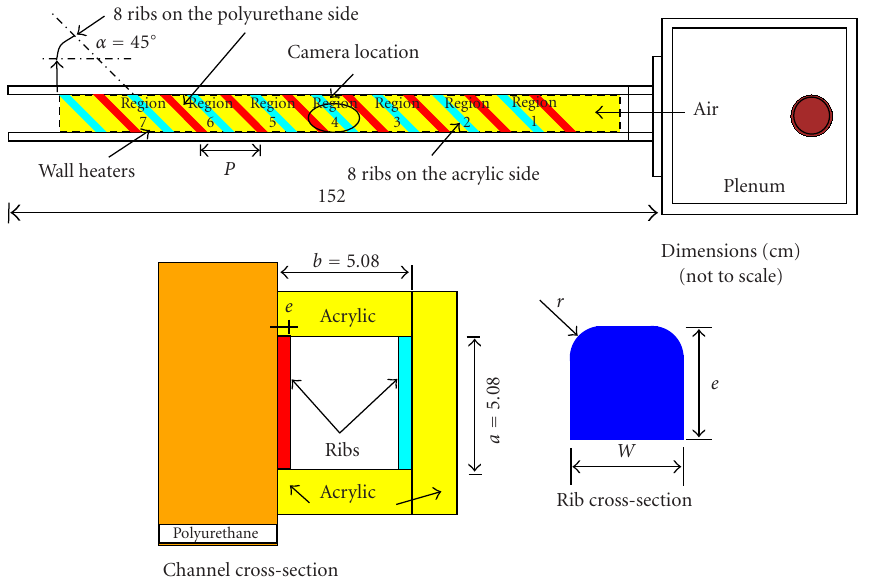
Figure 3: Schematics of a typical test section and ribs.